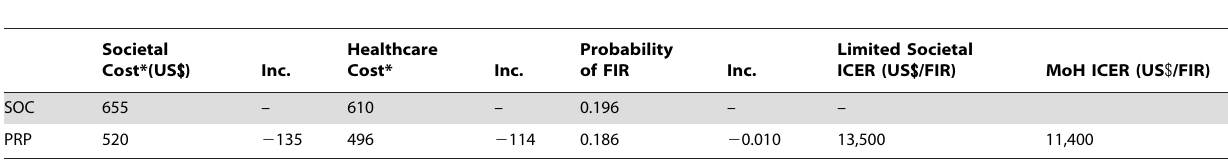
SOC group. At follow-up, 18.9% of cohort members had a FIR, 19.6% in the PRP group and 18.6% in the SOC group. Median CD4 lymphocyte count increase between baseline and follow-up was 53 cells/ m l in the PRP group and 128 cells/ m l in the SOC group. At follow-up the proportion of patients with CD4 less than 200 cell/ m l, 200–350 cells/ m l, 350–500 cells/ m l and above 500 cells/ m l were 30.0%, 15.1%, 39.4%, 25.5%, 19.9% respectively in Table 3. Mean and incremental costs, probability of CD4 cell count over 500 cell/ul at 1 year and cost-effectiveness comparing PRP and standard care in patients on antiretroviral treatment at the IDI clinic, Kampala, Uganda.